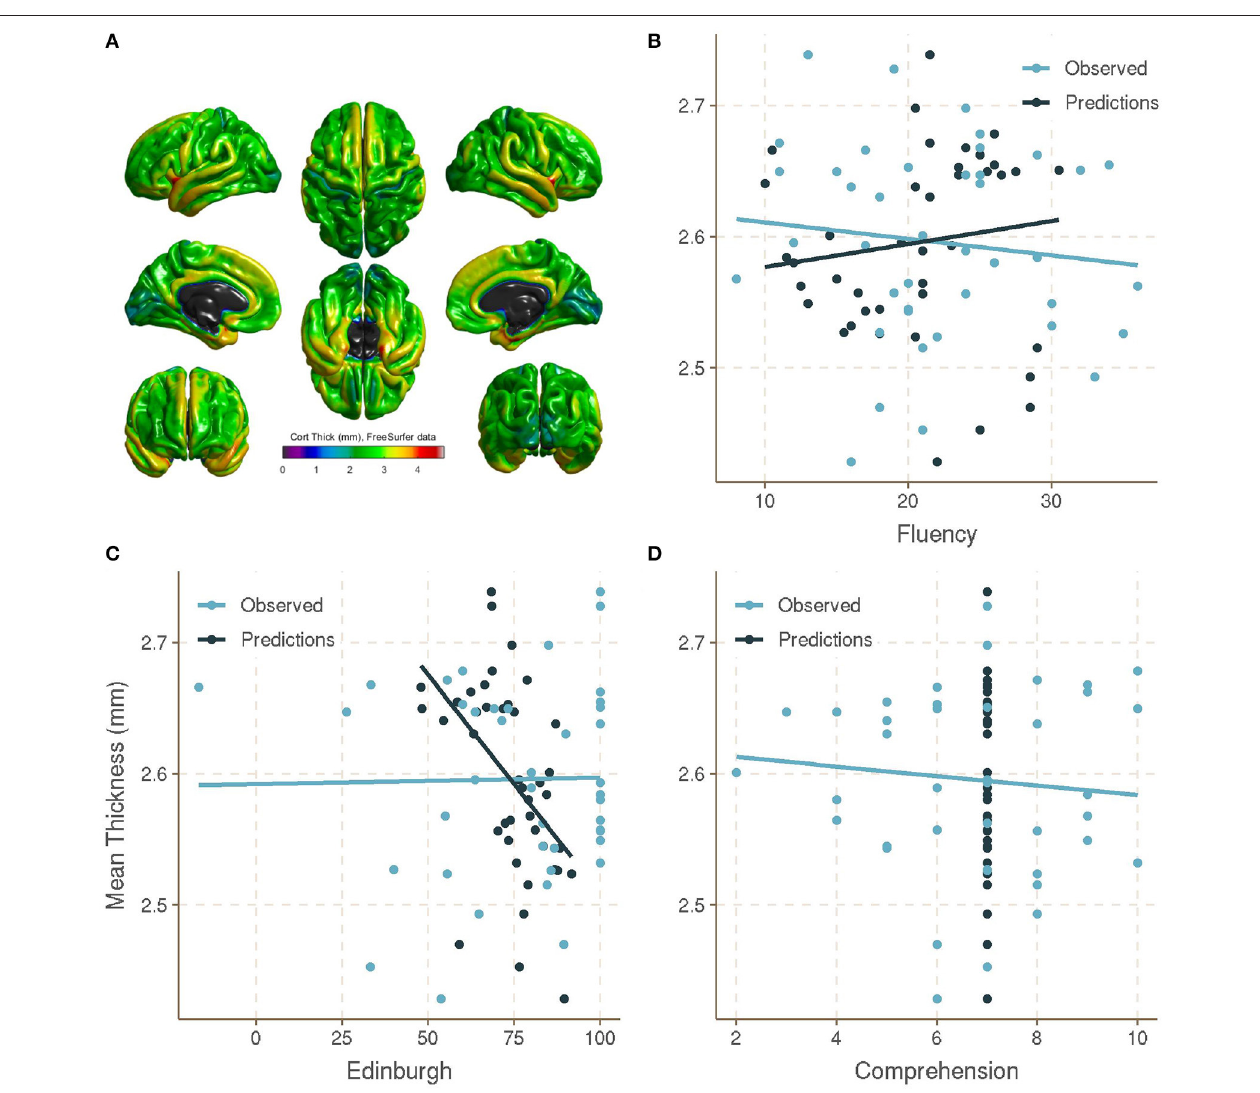
FIGURE 1 | (A) Mean cortical thickness extracted using FreeSurfer processing and parcellated with Desikan-Killiany Atlas. (B) Scatterplots of observed Verbal Fluency values (x axis) and mean cortical thickness (mm) (y axis) and K-nearest neighbor (KNN)-predicted values for Verbal Fluency, (C) Edinburgh Handedness Inventory (EHI) coefficients, and (D) Short-Story Task (SST) comprehension